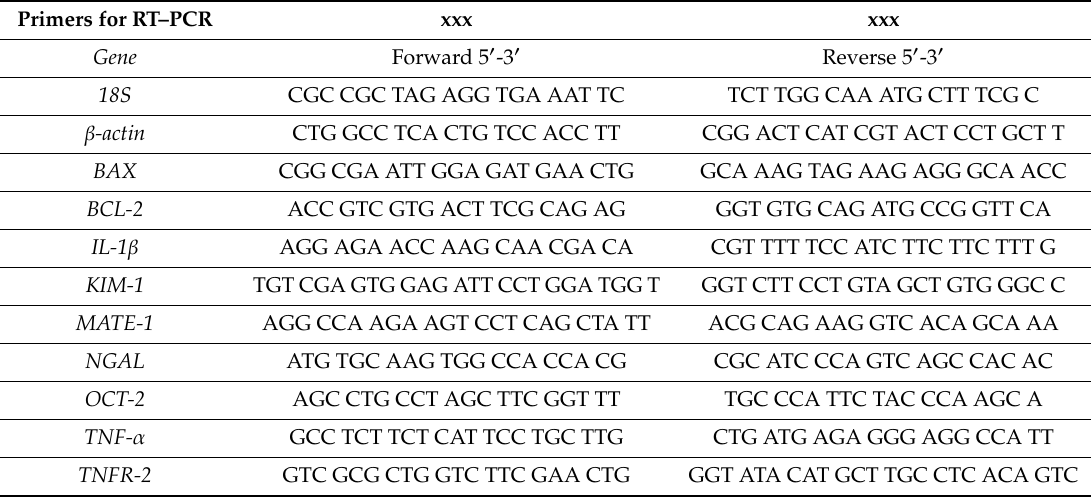
Table 2. Sequences of the primers used for real-time PCR